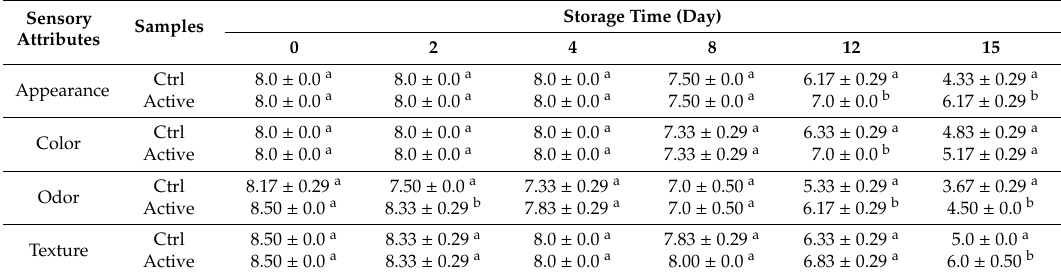
a,b Data (±SD n = 2) with different superscript letters in each column for each attribute are significantly different ( p < 0.05). Ctrl = breaded cod sticks without olive paste; Active = breaded cod sticks with olive paste.